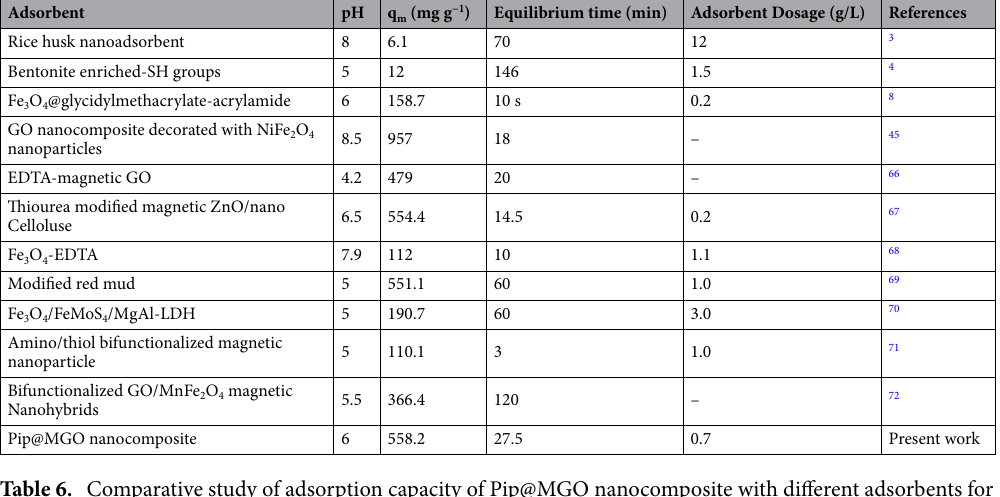
Table 6. Comparative study of adsorption capacity of Pip@MGO nanocomposite with different adsorbents for removal of Pb